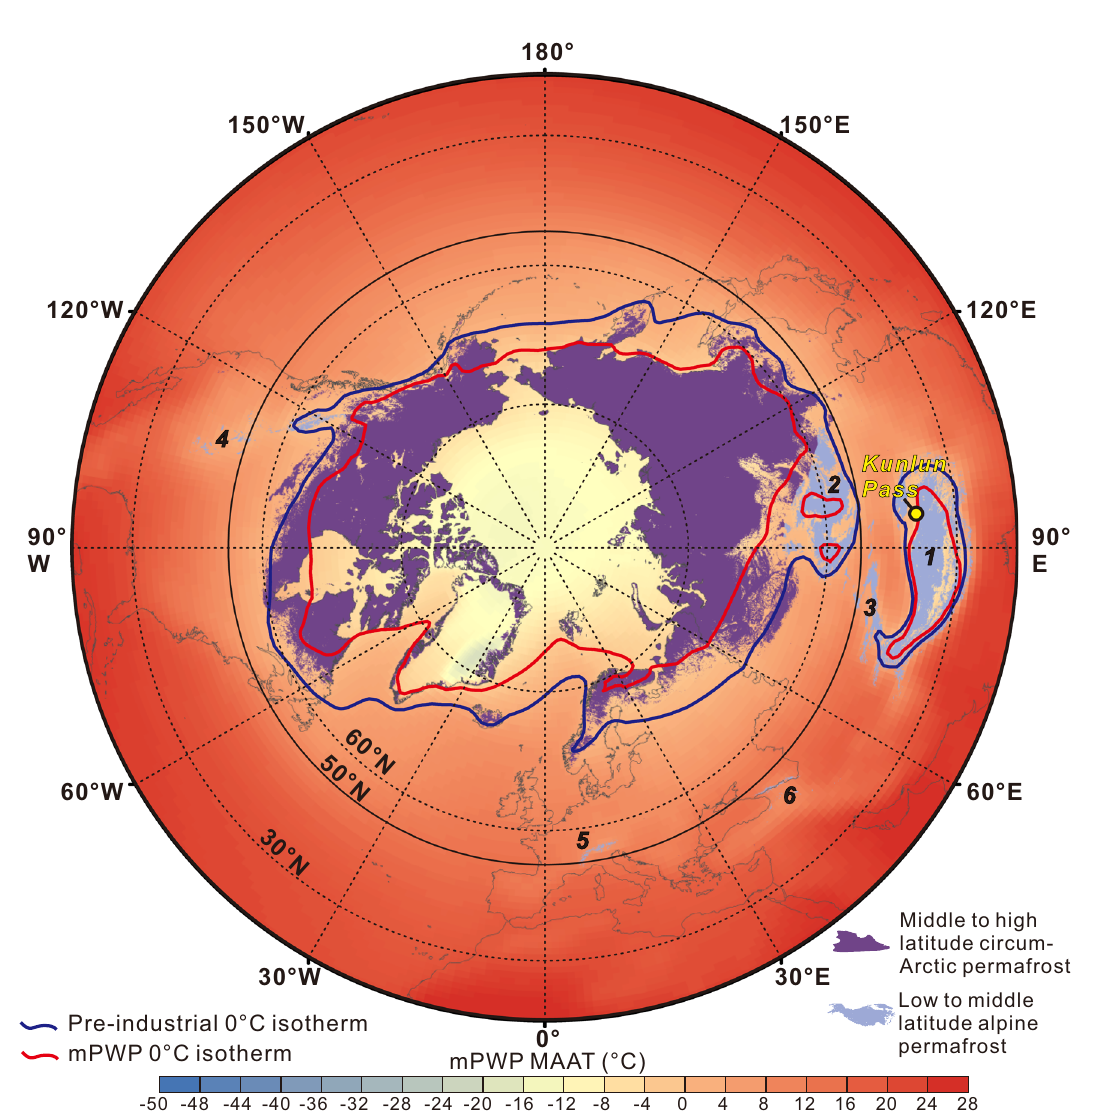
Fig. 4 Simulated mean annual air temperature (MAAT) during the mid-Pliocene Warm Period (mPWP). a Pliocene Model Intercomparison Project Phase 2 (PlioMIP2)-based climate model simulation 68 , showing MAAT and the 0 °C isotherm during the mPWP and pre-industrial period, respectively. Region marked with 1-6 refers to the Tibetan Plateau-Pamir, Altai Mountains-Mongolia-Yablonoi-Sayan, Tian Shan, Rocky Mountains, Alps, and Caucasus,